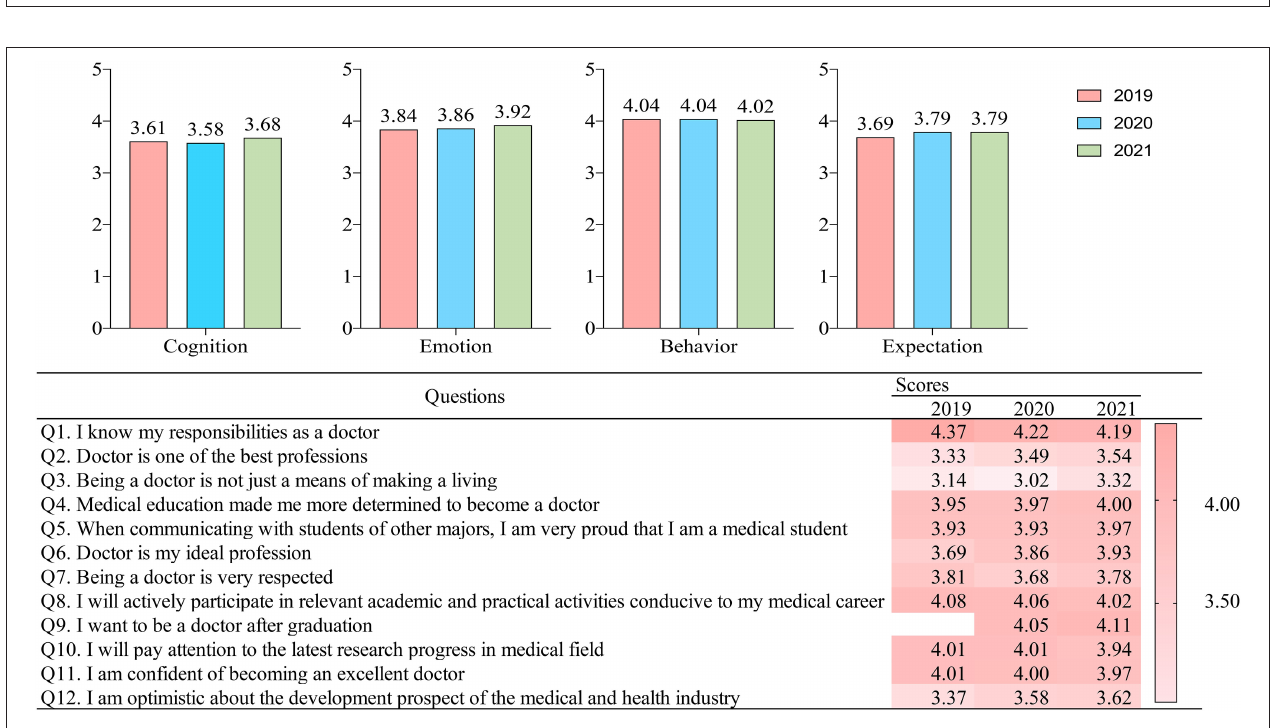
FIGURE 3 | Results of professional identity scale. Professional Cognition is represented by Q1 to Q3; Professional Emotion is represented by Q4 to Q7; Professional Behavior is represented by Q8 to Q10; and Professional Expectation is represented by Q11 and